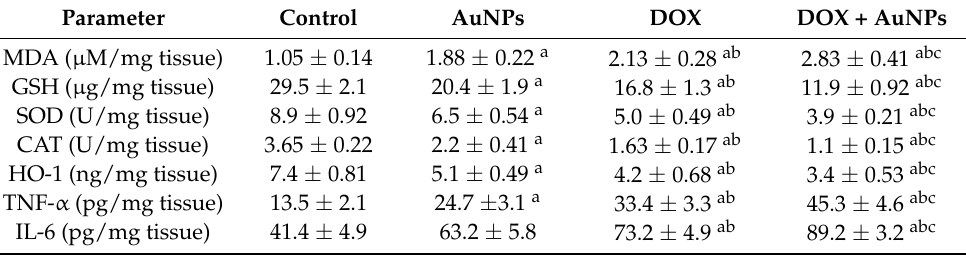
Table 3. Effects of the individual or combined treatments with gold nanoparticles (AuNPs) and/or doxorubicin (DOX) on selected markers of oxidative stress and inflammation in the liver of all experimental groups.